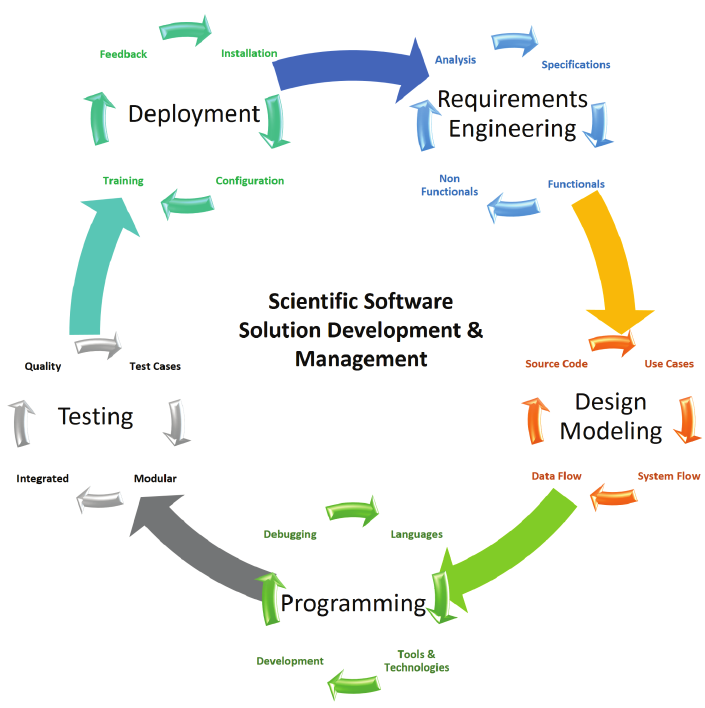
Figure 1. Scientific Software Engineering (SSE). SSE integrates and combines in a development cycle the following independent main modular approaches: requirements engineering, design modeling, programming, testing and deployment. Each approach consists of its own sub-modular, integrated and cyclic combination of internal phases: requirement engineering consists of specification, functionals, non- functionals, and analysis; design modeling consists of use cases, system flows, data flow and source code; programming consists of languages, tools and technologies, development, and debugging; testing consists of test cases, modular, integrated and quality; finally, deployment consists of installation, configuration, training, feedback. Iterative cycles lead to continuous improvement. Achievements translate the goals in good software.